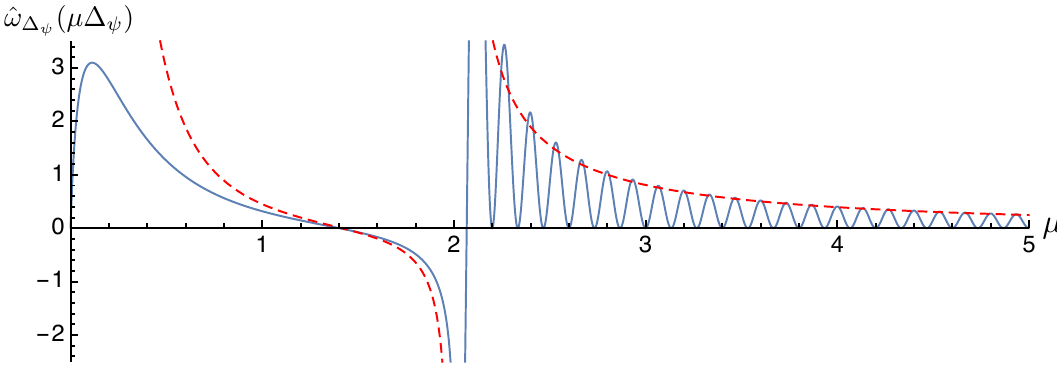
Figure 11 . The analytic extremal functional for (cid:1) = 15. The blue curve represents ^ ! [ v ( (cid:22) )] (cid:0) (cid:1) ! (cid:1) ( (cid:22) (cid:1) ) with v ( (cid:22) ) given by (6.12) and ! (cid:1) ((cid:1)) given by (5.16). ^ ! (cid:1) ( (cid:22) (cid:1) ) in the region 0 < (cid:22) < 2 converges to the red dashed curve given by p 2 (cid:25) (cid:0) 1 (cid:22) (cid:0) 5 = 2 ( (cid:22)